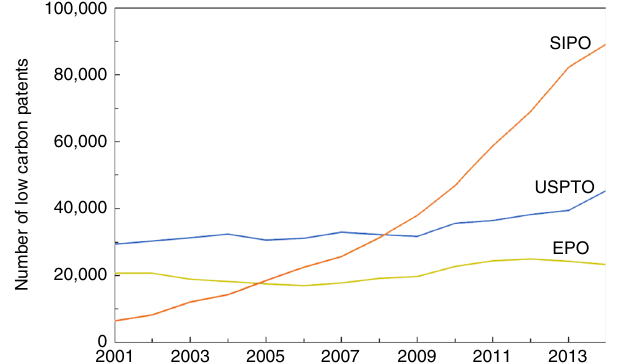
Fig. 1 Annual low-carbon patent application at the Chinese, US and EU patent of fi ces. SIPO patents are available via its website (http://www.sipo. gov.cn/zhfwpt/zljs/). USPTO and EPO patents are available via EPO ’ s PATSTAT database (https://www.epo.org/searching-for-patents/ business/patstat.html#tab-1). The scope of low-carbon innovation is the same as used in the main estimation (see Methods section) with reference to the IPC Green